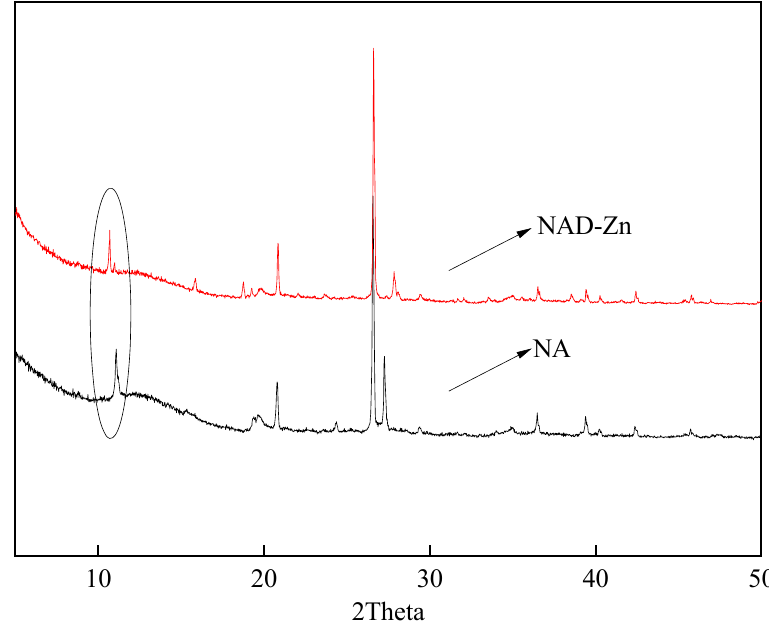
Figure 8. The XRD spectrum of NAD – Zn.